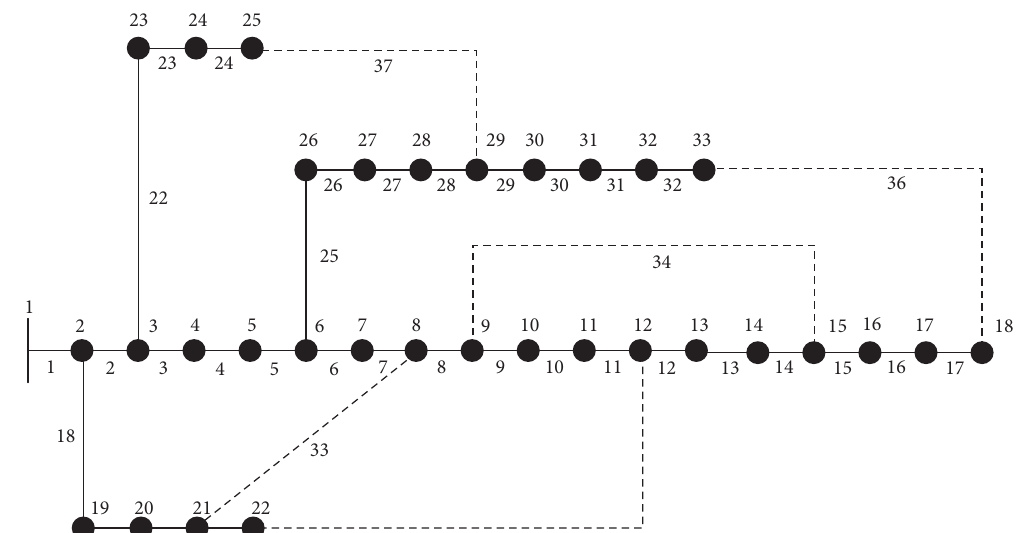
Figure 6: The 33-node test system.